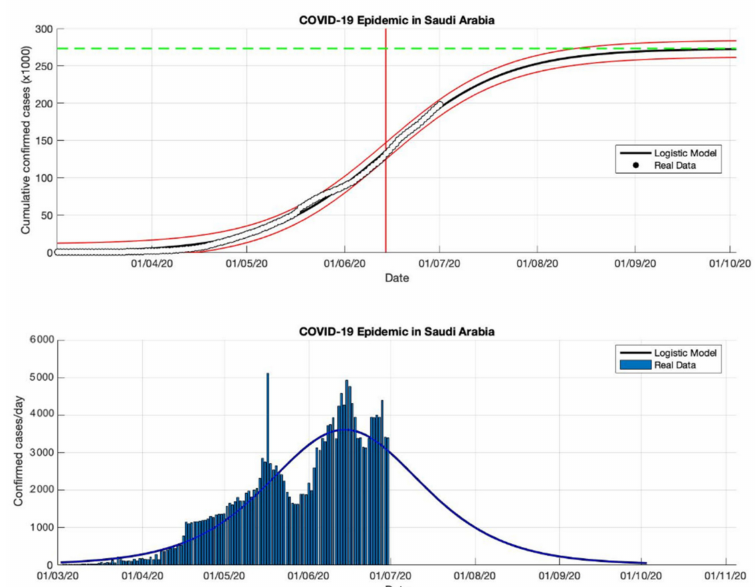
Figure 9. In the above figure, the prediction results of the logistic growth model for cumulative infected cases are compared with the actual data, while the two red lines between the black lines represent a prediction error limit of about 5%. The dashed green line predicts the total size of infected cases in the final phase of the epidemic. The red line intersects the cumulative case curve to predict the turning point or peak point of the epidemic (this line is parallel to the top of the curve from the below figure). In the below figure, the prediction results of this model for daily infected cases